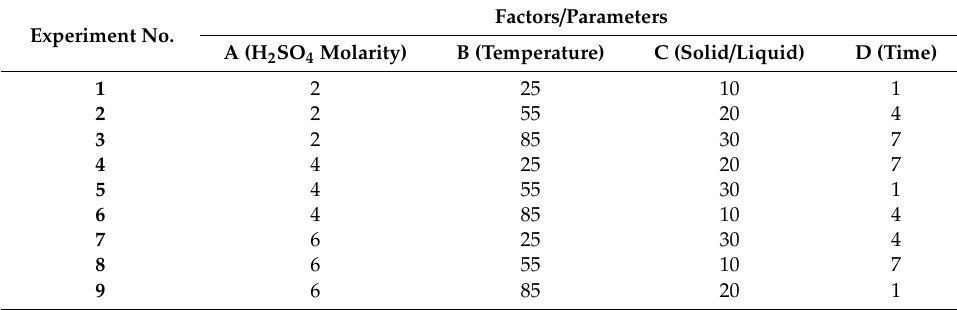
Table 2. L 9 (3 4 ) orthogonal matrix experimental